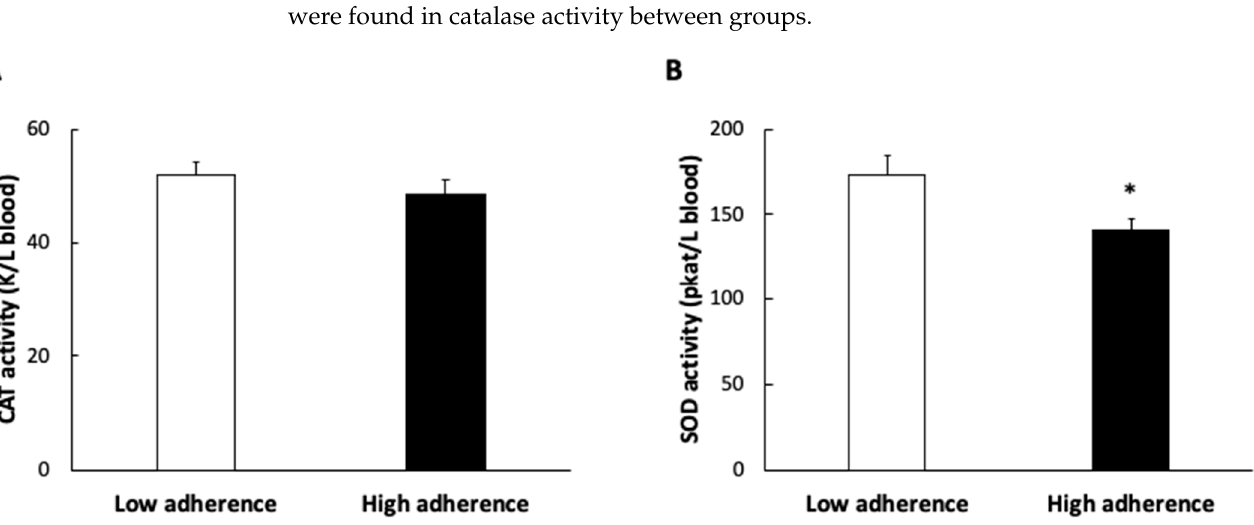
Figure 2. Plasma catalase (CAT) enzymatic activity ( A ) and superoxide dismutase (SOD) enzymatic activity ( B ) of patients according to the Mediterranean Dietary Pattern score. Results are presented as mean ± SEM. Data points in bold (*) are significant ( p < 0.05) by Student t -test. MPO activity (Figure 3) was also higher in the group with lower adherence to the MDP.